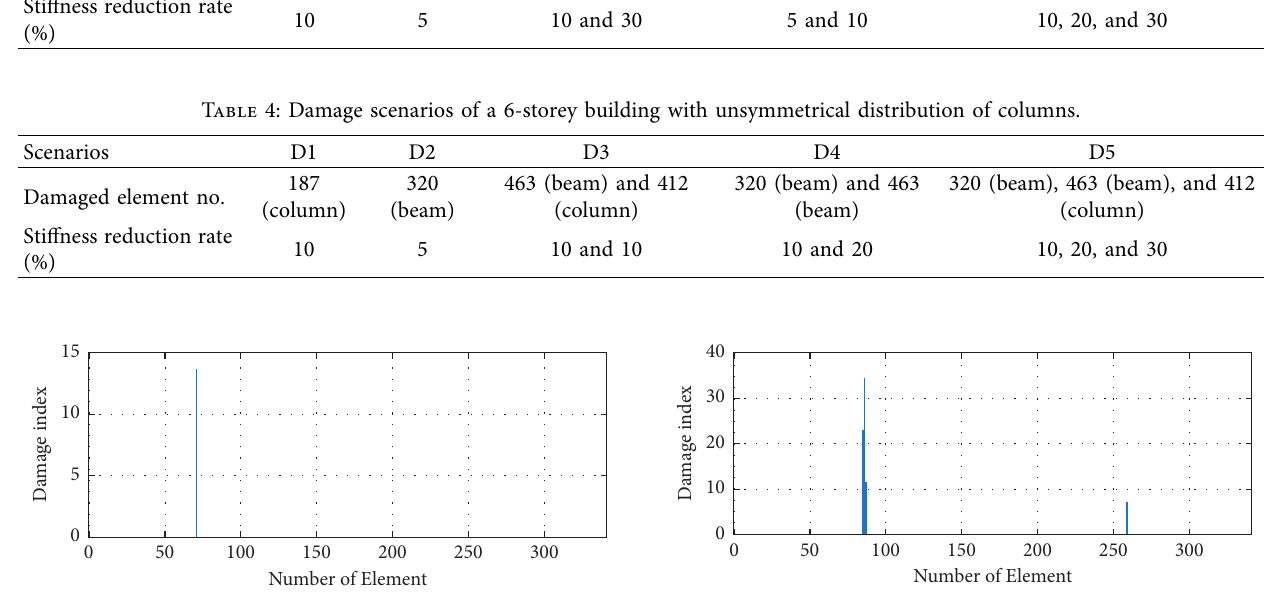
Figure 7: Results of D1 using MCA-DI (L-shape building).